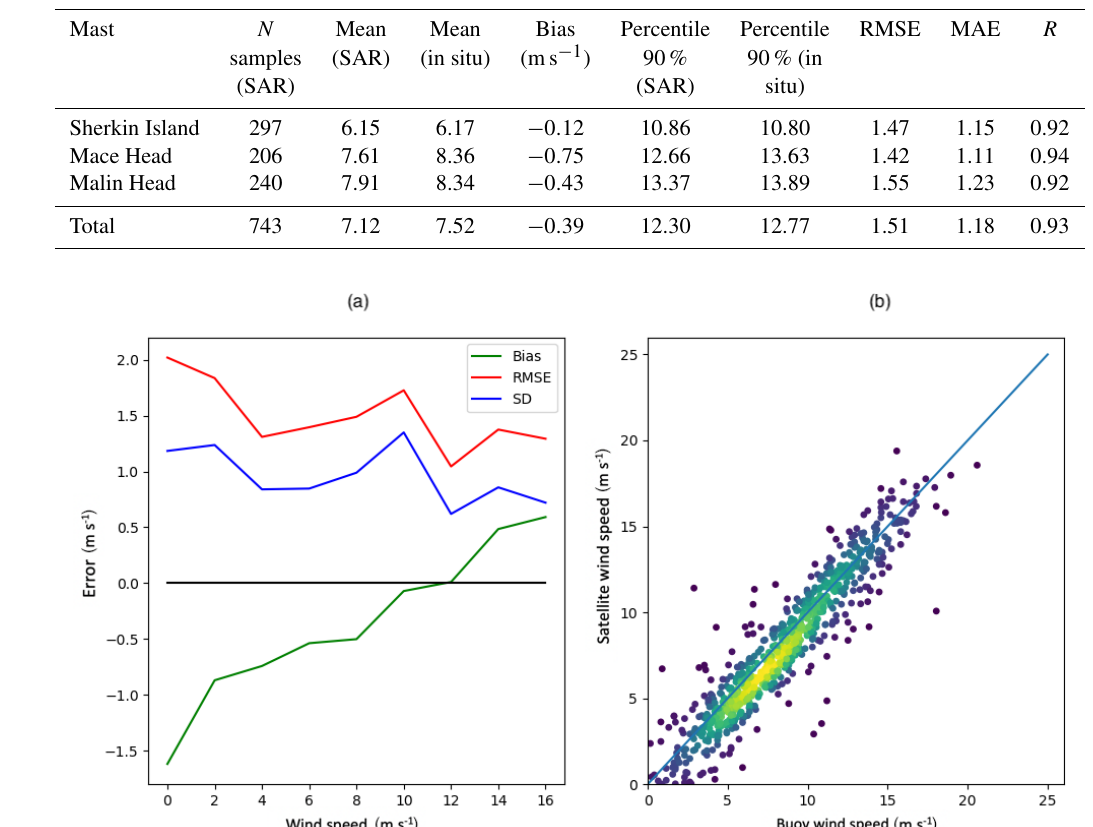
Table 5. Results of the match-up comparison of satellite-measured wind speeds with in situ measured wind speeds from coastal weather stations.